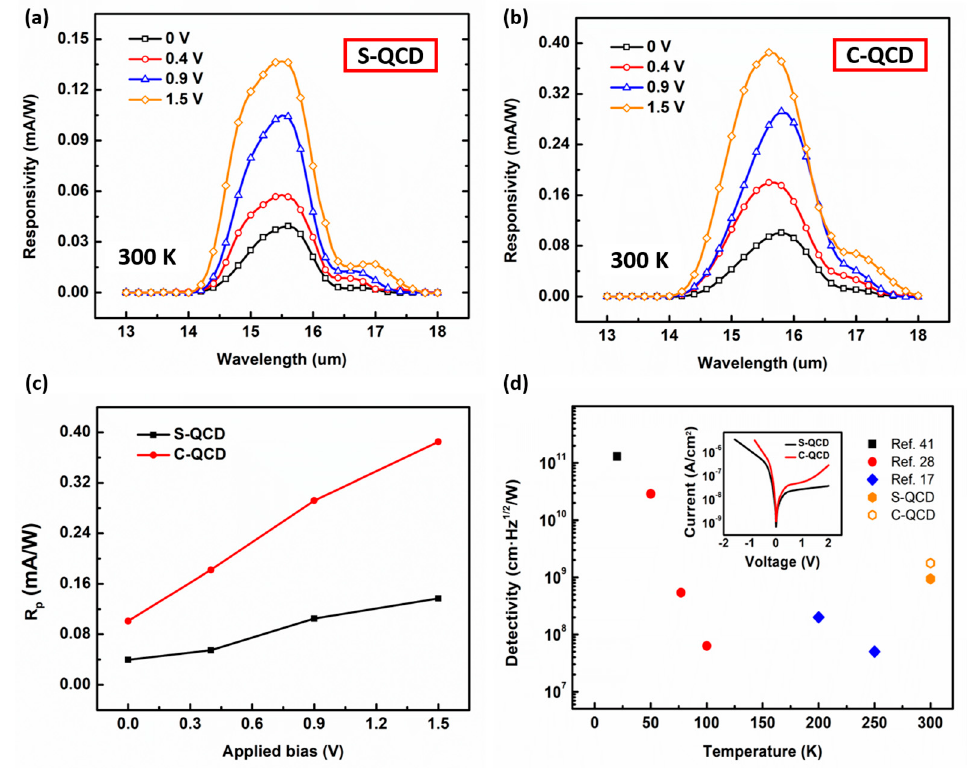
Figure 5. Response performance and detectivity. The responsivity of ( a ) S-QCD and ( b ) C-QCD under different applied biases. ( c ) Peak responsivity ( Rp ) of the two QCDs as a function of the applied bias at 300 K. ( d ) Detectivity D* of the two QCD devices at 300 K. Inset: current density as a function of the bias under the illumination by a blackbody at 300 K.